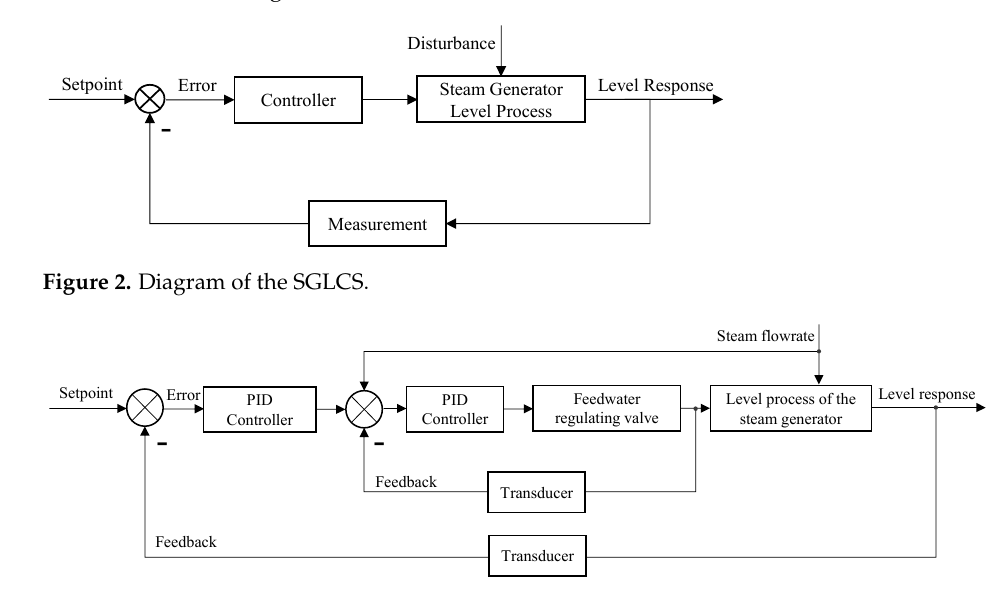
Figure 3. Three − impulse cascade PID control structure of the SGLCS.